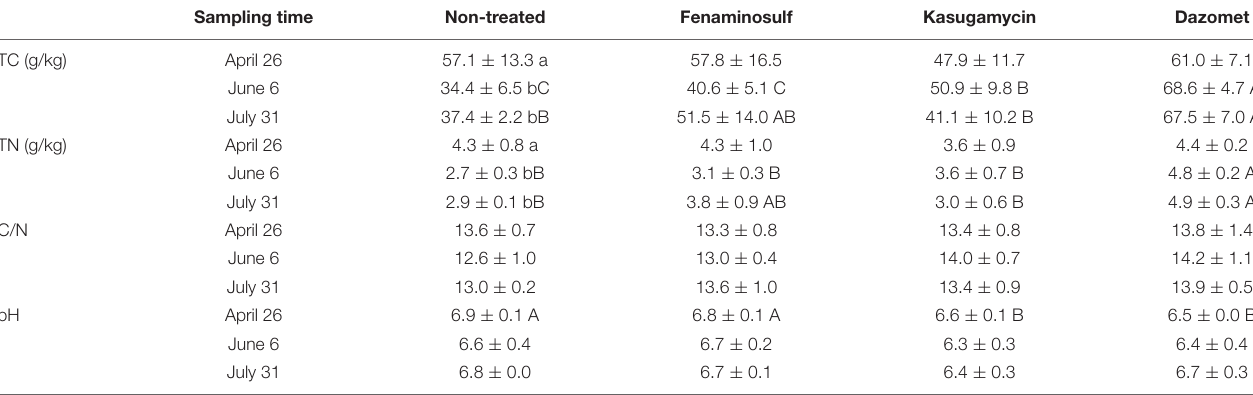
TABLE 1 | Chemical properties of soils treated with disinfectants, 2018. Sampling